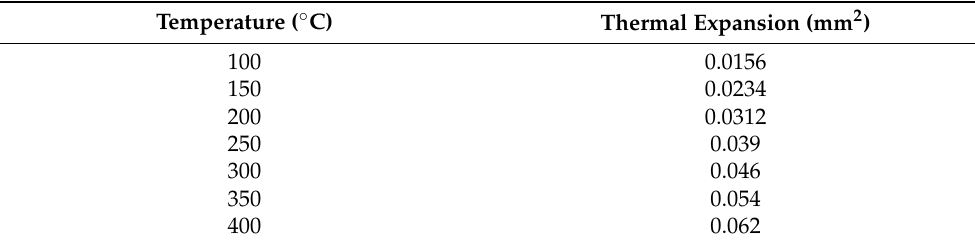
Table 3. The thermal expansion of silver